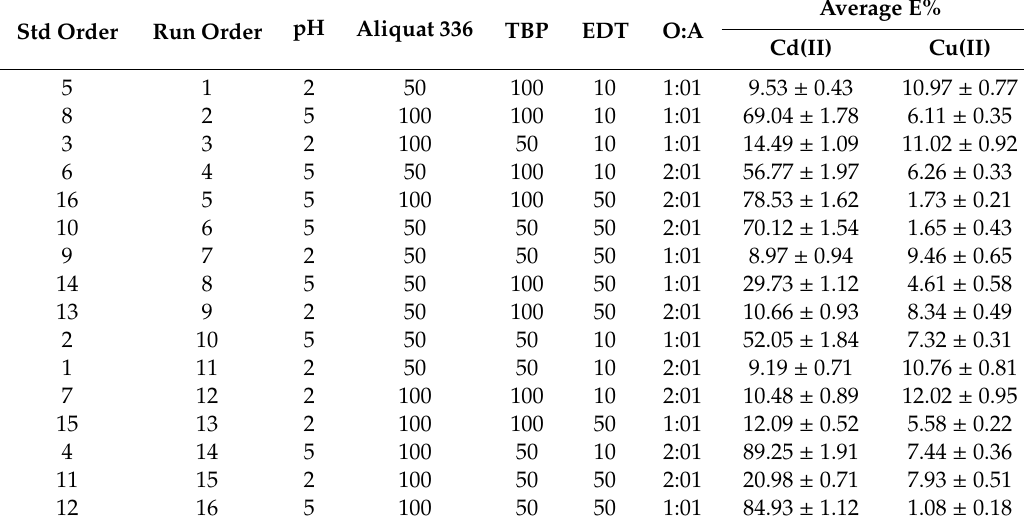
Table 2. Screening using 2 5 − 1 fractional factorial design and average E% of Cd(II) and Cu(II) using Aliquat 336 and TBP in toluene and EDTA as masking agent; diluent: toluene; operating